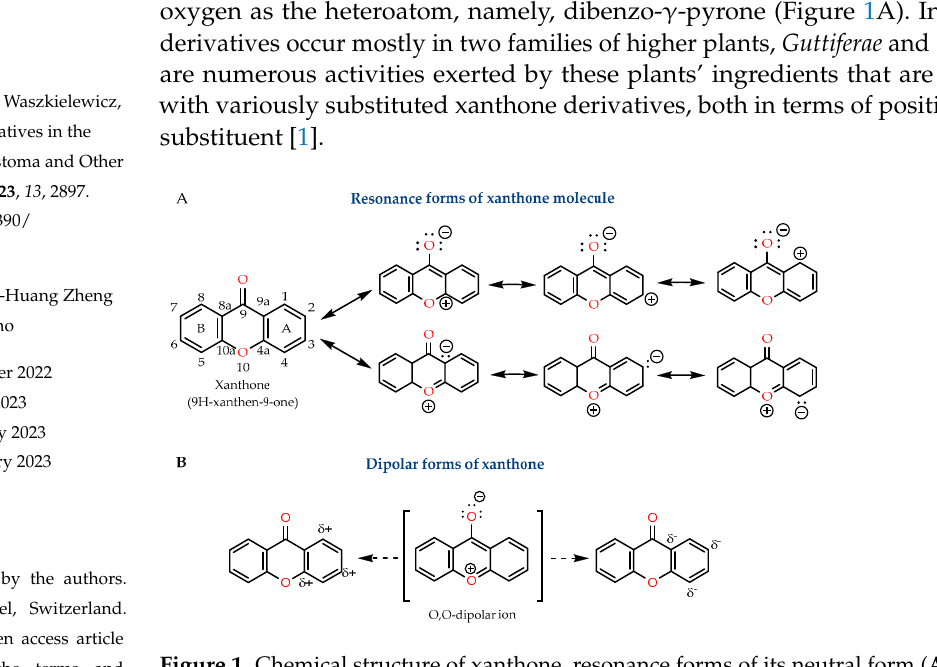
Figure 1. Chemical structure of xanthone, resonance forms of its neutral form ( A ) and structure of its O,O-dipolar ion ( B ) [2].